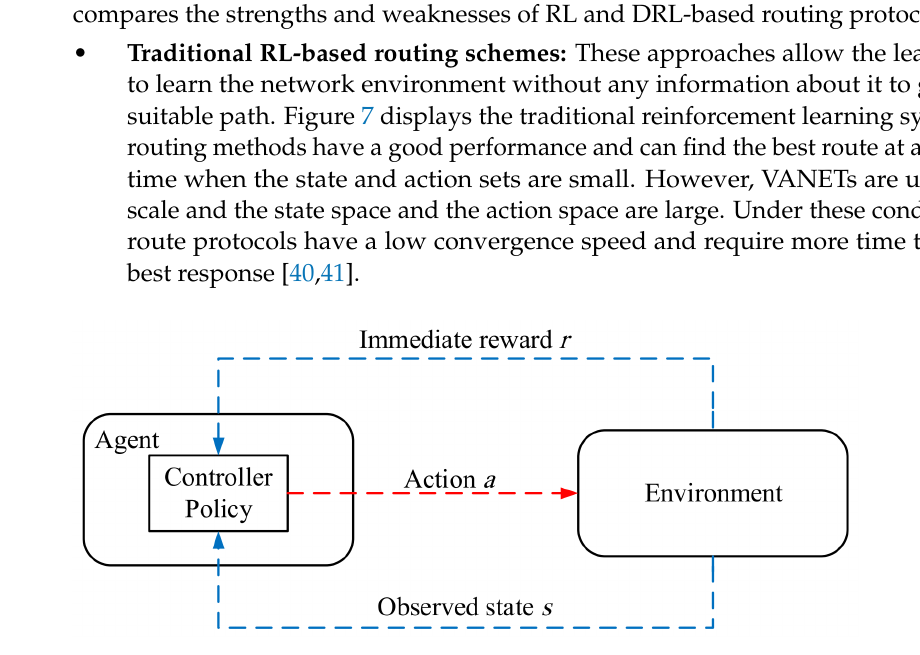
Figure 7. Traditional reinforcement learning system.